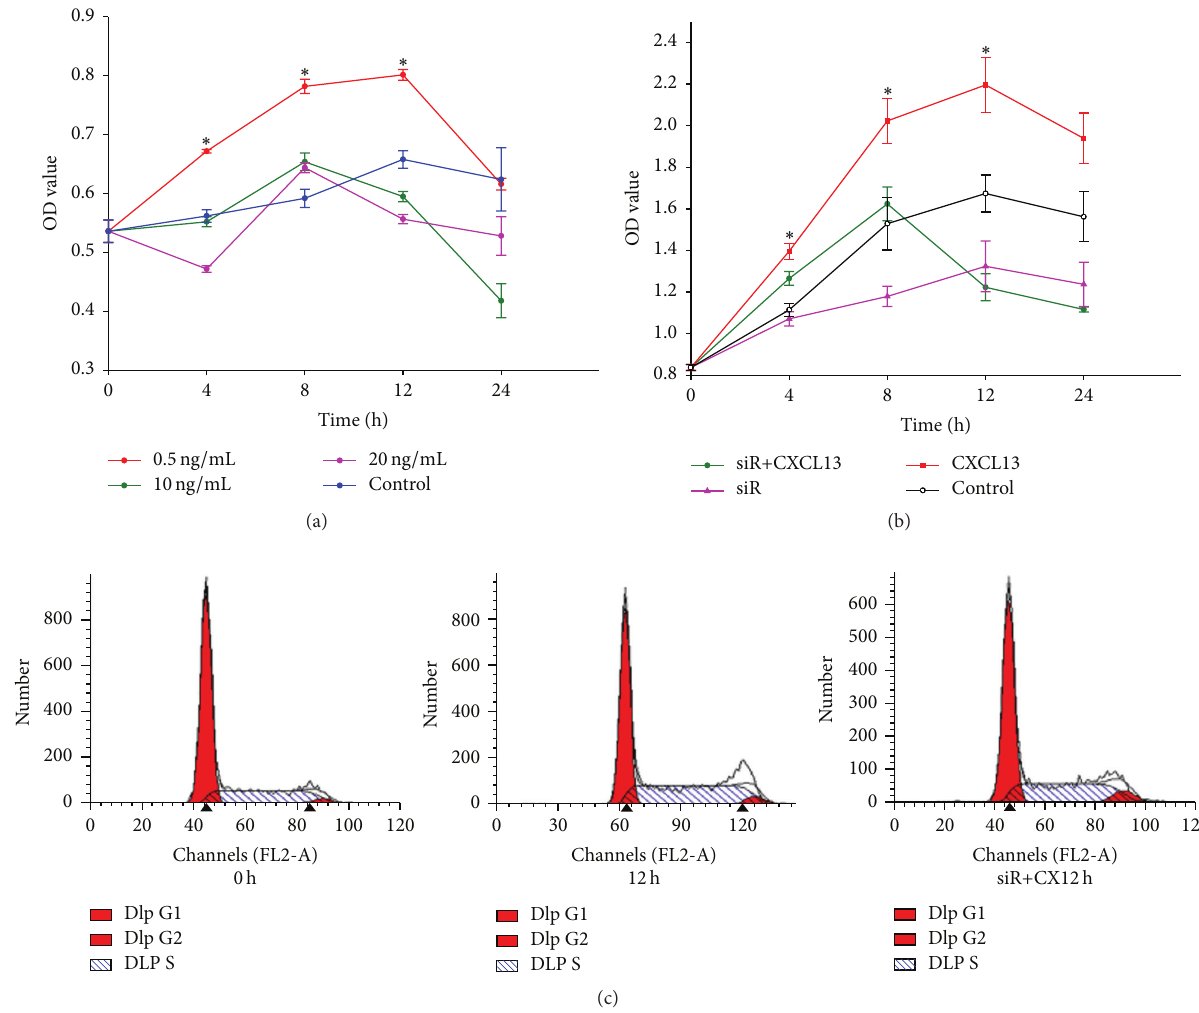
Figure 2: CXCL13 promoted the proliferation of HRMCs. (a) Cells were treated with CXCL13 at 0.5 ng/mL, 10ng/mL, and 20 ng/mL. 0.5 ng/mL (500pg/mL) was optimal concentration. (b) With 500 pg/mL CXCL13, the proliferation ability of HRMCs was shown. Both 𝑃 values of CXCL13 versus control and siR + CXCL13 versus CXCL13 were less than 0.05. (c) Cell cycles of HRMCs with CXCL13 for 0h and 12handtransfectedcellsfor12 hwereshown.ResultsindicatedthatCXCL13promotedcellstoenterSphase.However,theeffectwasweakened after the silence of CXCR5. ∗ 𝑃 < 0.001